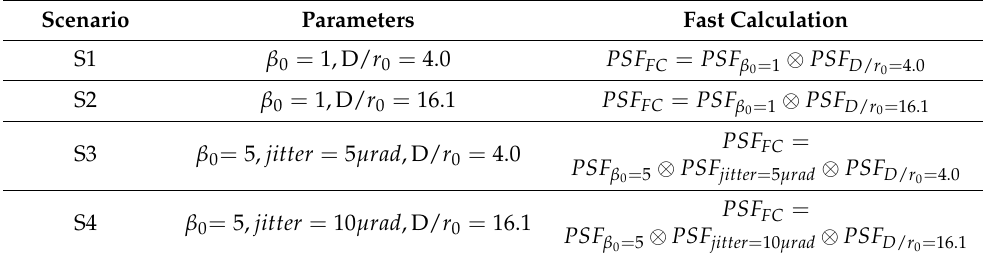
Figure 6. 4D wave optics simulation results ( a – d ) and the far-field intensity distribution for fast calculation results ( e – h ) with S1, S2, S3, and S4 scenario pairs presented top to bottom, respectively. The center to outermost calibration rings around the central propagation axis in this and subsequent figures have arbitrarily sized diameters to represent the diffraction-limit, 5.0 times diffraction limit, 10.0 times diffraction limit, and 15.0 times diffraction limit, respectively. Table 3. Fast calculation with PSF convolution